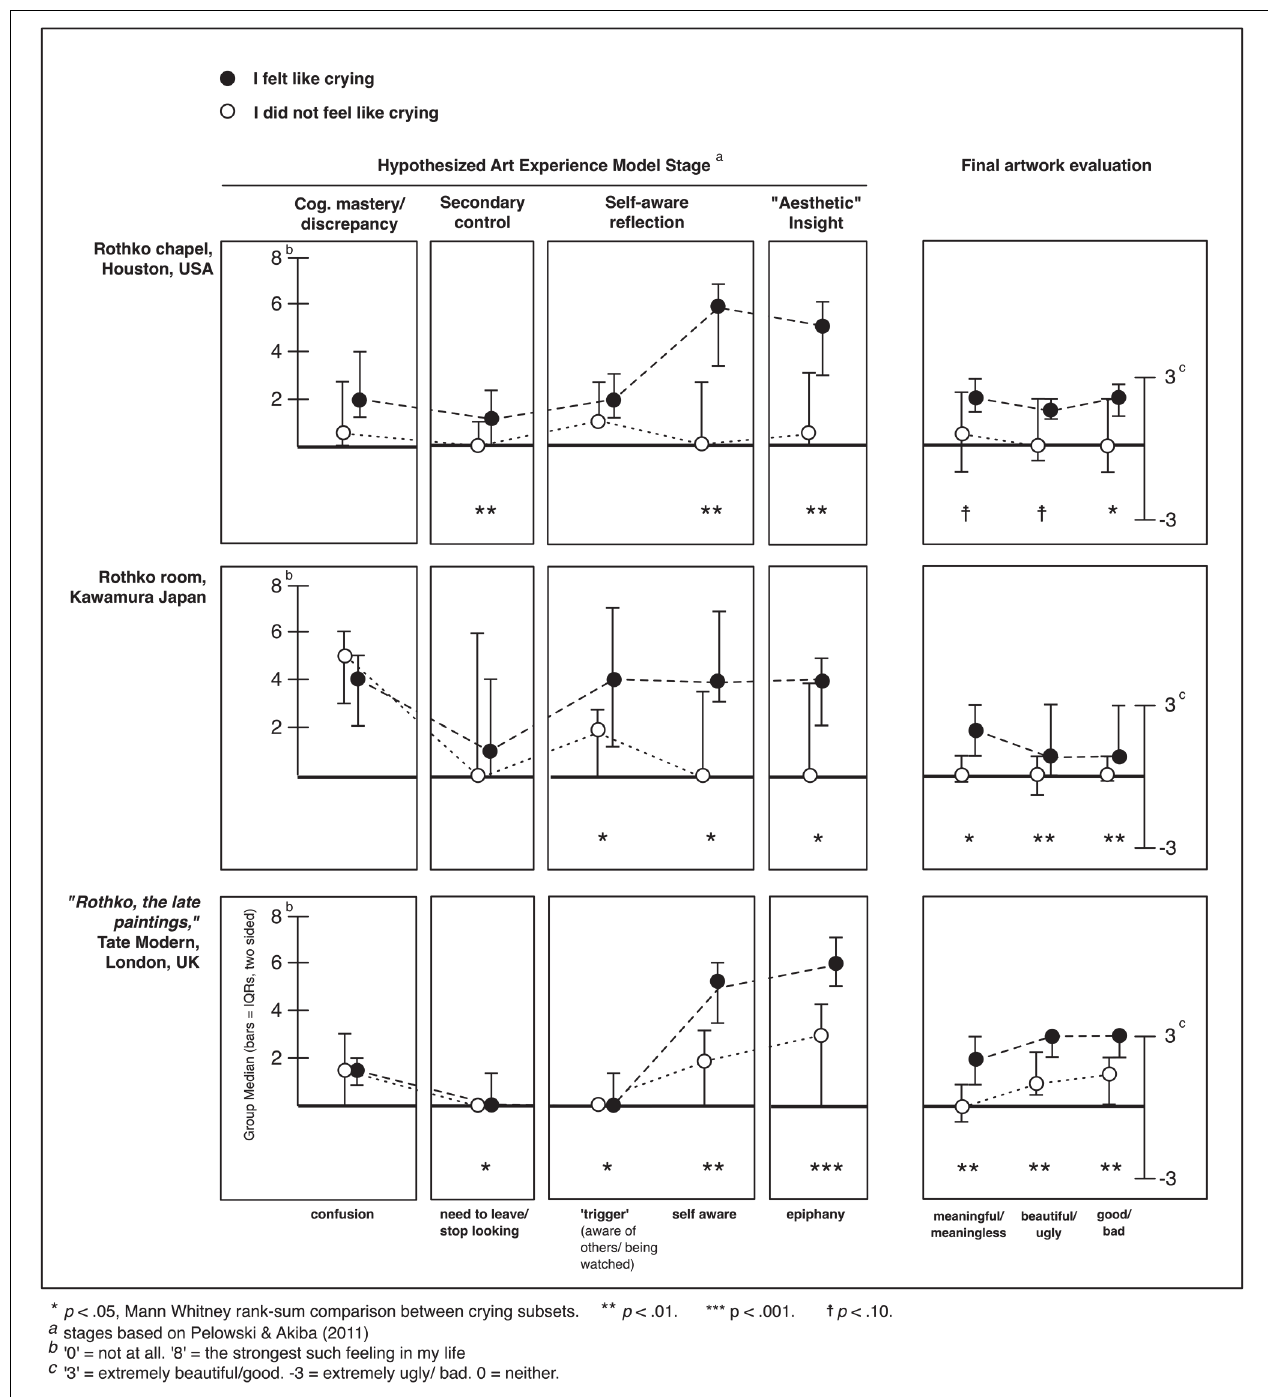
FIGURE 7 | Comparison of key emotions and artwork evaluations between viewers who did or did not “feel like crying” in three encounters with museum